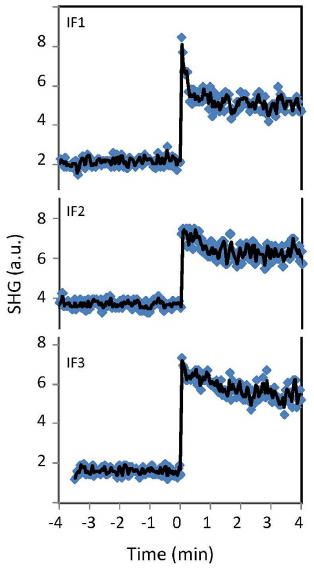
Figure 5. Typical variation in the SHG intensity around the im- mersion freezing points for IF1, IF2, and IF3 during the cooling